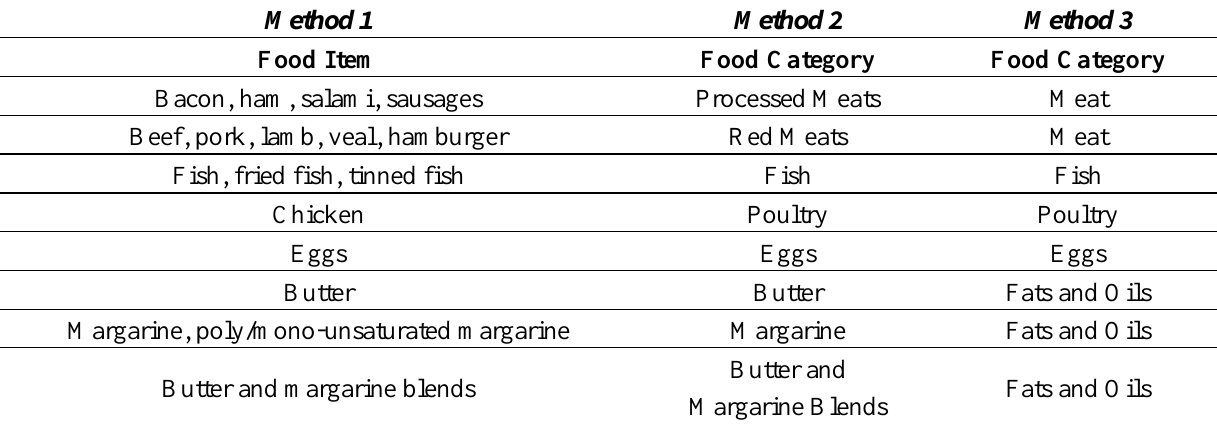
Table 1. Food groupings used in the dietary pattern